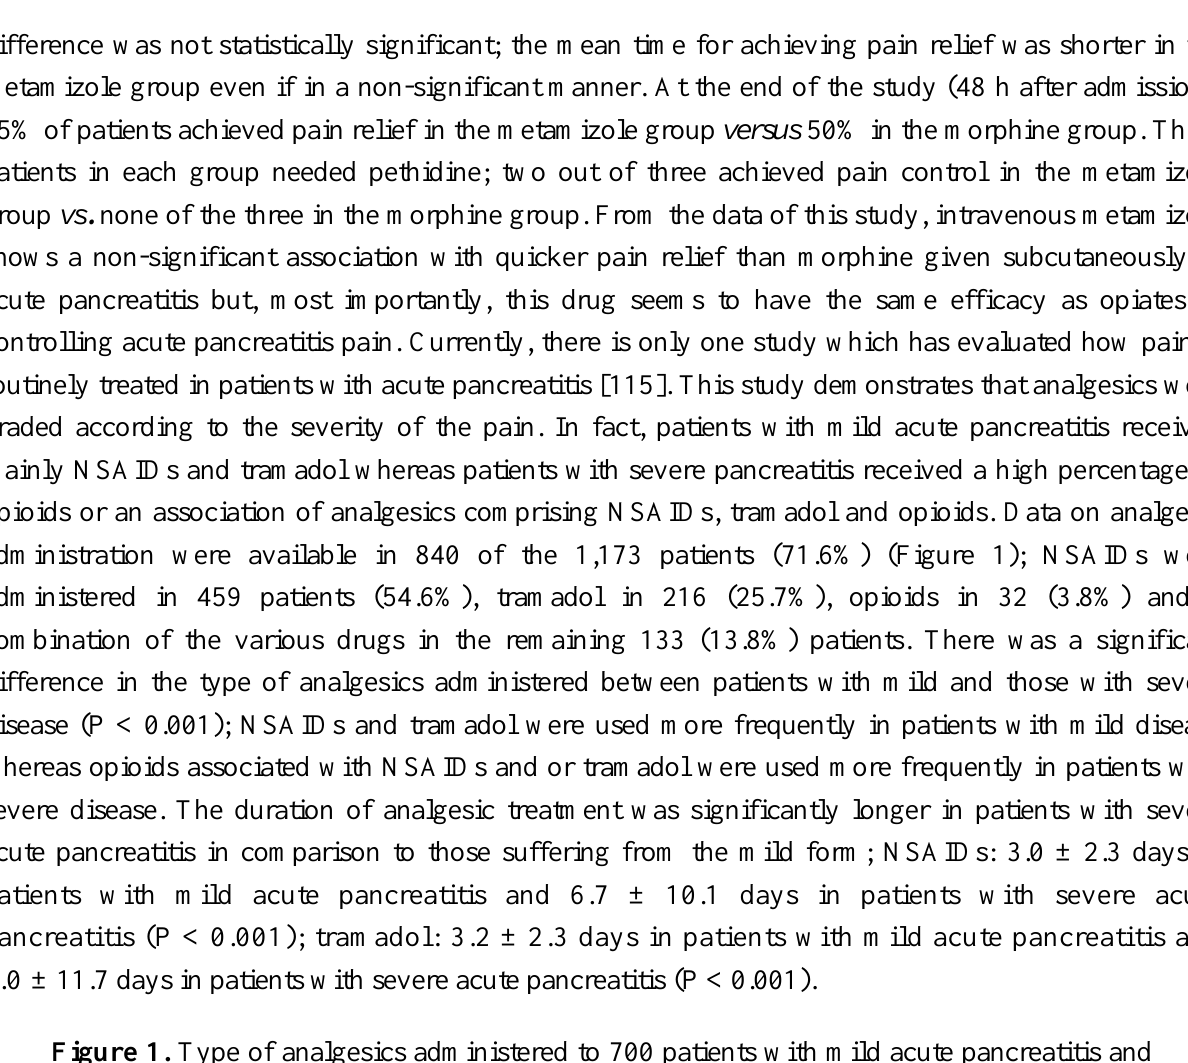
Figure 1. Type of analgesics administered to 700 patients with mild acute pancreatitis and to 140 with severe acute